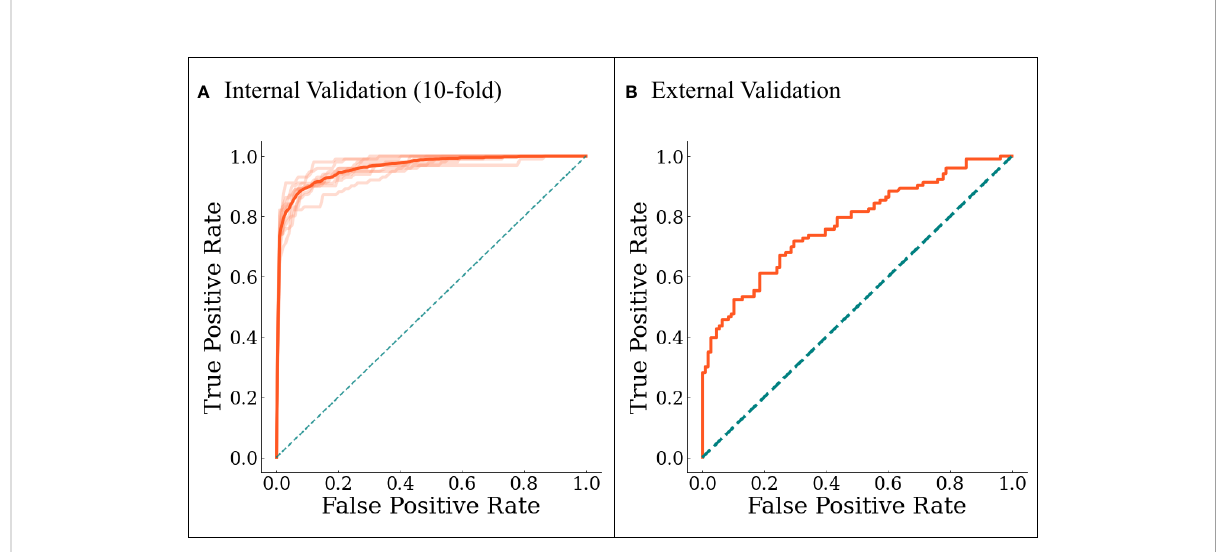
FIGURE 4 The ROC curves for (A) internal 10-fold cross-validation and (B) external validation. In (A) , darker line represents the averaged